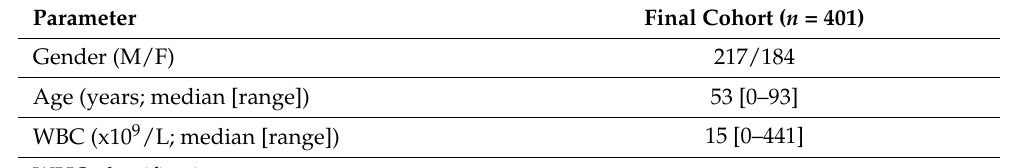
Table 1. Patient characteristics (final cohort, n =